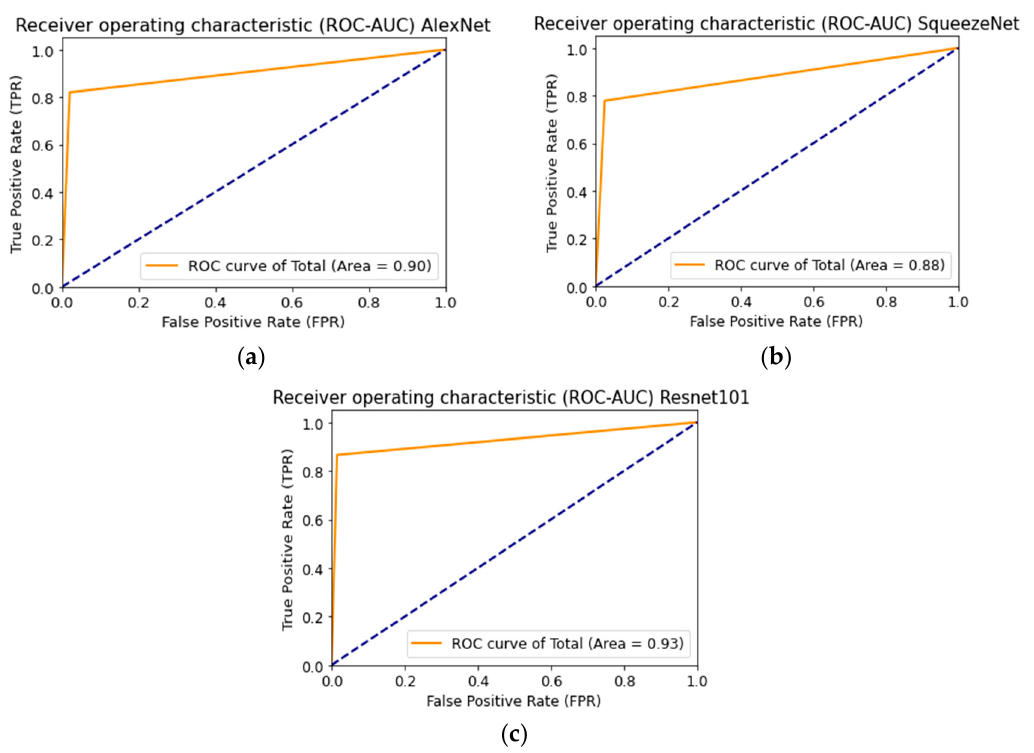
Figure 18. Receiver operative characteristics (ROC) curve when testing a multimodal neural network system for recognizing pigmented lesions and skin based on CNN: ( a ) AlexNet; ( b ) SqueezeNet; ( c ) ResNet ‐ 101.